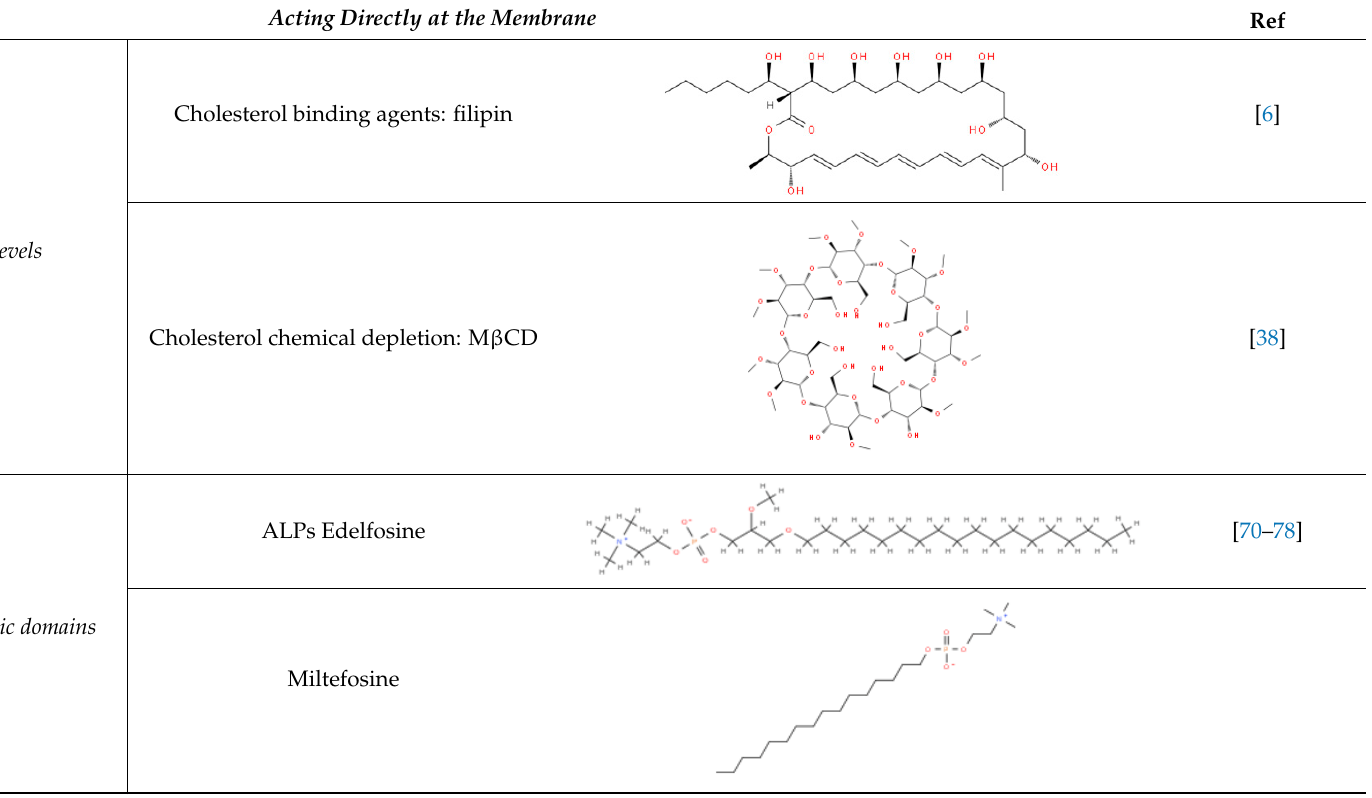
Table 1. Overview of selected therapeutic agents targeting multiple steps in lipid localization and synthesis to modulate membranes. Chemical structures were obtained from ChemSpider, a free chemical structure database owned by the Royal Society of Chemistry (http://www.chemspider.com/).